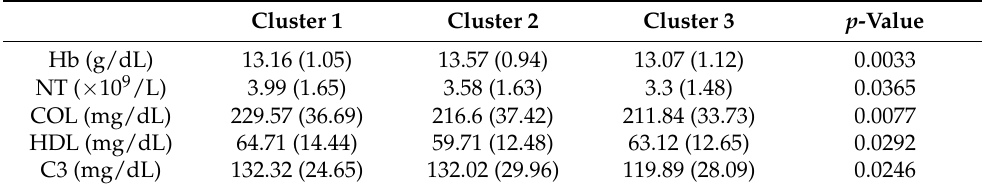
Table 3. Blood analytic differences between symptom-based case clusters. Data are presented as mean ± (SD) for each biochemical